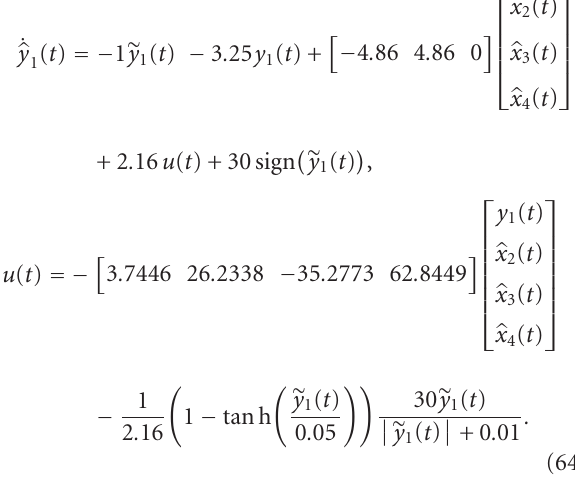
Figure 3: Responses of system states x 1 , x 2 , and x 3 for Example 5.